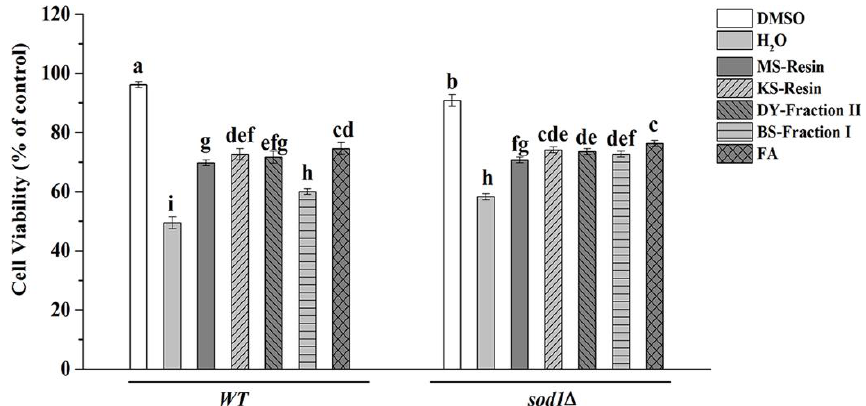
Figure 3. Effect of herbal teas and green teas on survival rates of yeast cells stressed with 2.00 mM H 2 O 2. The data represented the means ± SD of at least three independent experiments. The capital letters mean statistically different results in two kinds of yeast cells; p < 0.05.